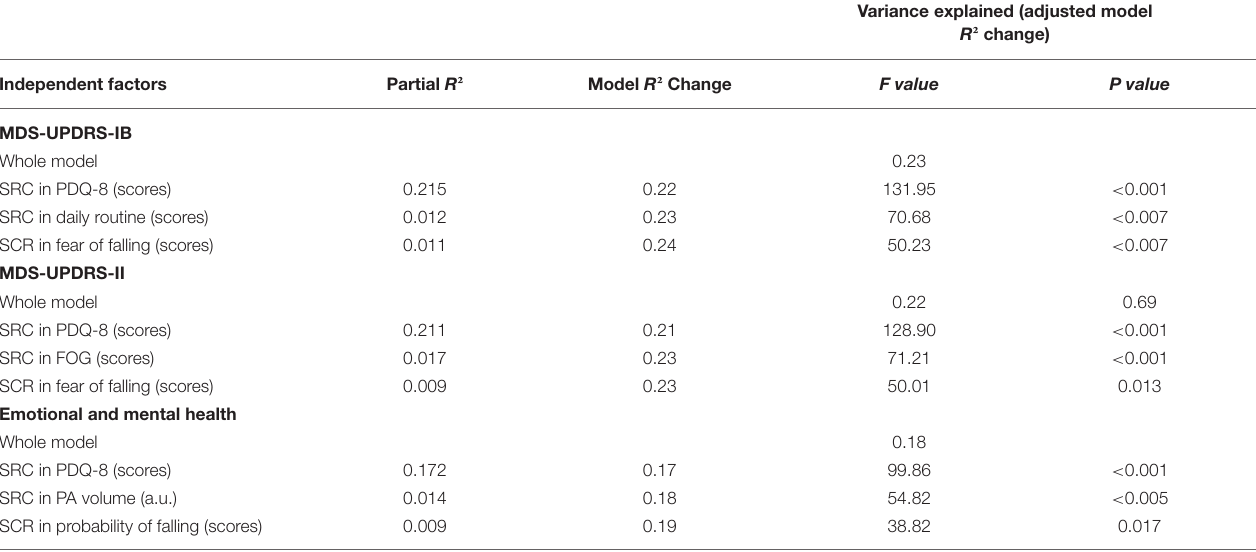
TABLE 2 | Linear multiple regressions (stepwise method) with included factors and MDS-UPDRS-IB, MDS-UPDRS-II, and emotional and mental health scores as dependent variables.